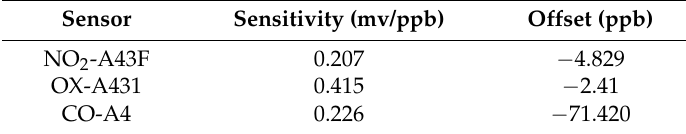
Table 4. Summary the new sensitivity and offset of each EC sensor.